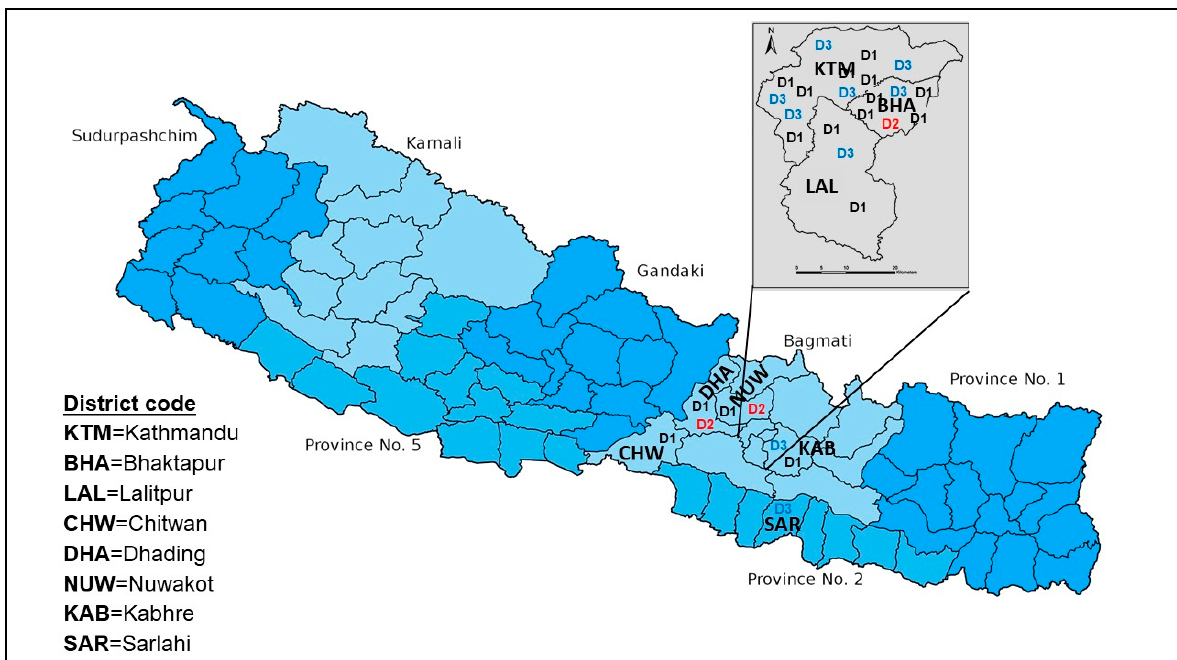
Figure 4. Spatial visual representation of the circulation of multiple DENV serotypes circulation in Kathmandu and surrounding districts in the 2022 outbreak. Regarding the molecular analysis of representative samples ( n = 150), 29 strongly PCR-positive samples also had a positive serotype result. Kathmandu valley reported three DENV serotypes (DENV-1, DENV-2, and DENV-3), with the majority of patients being infected with DENV-1 and DENV-3.